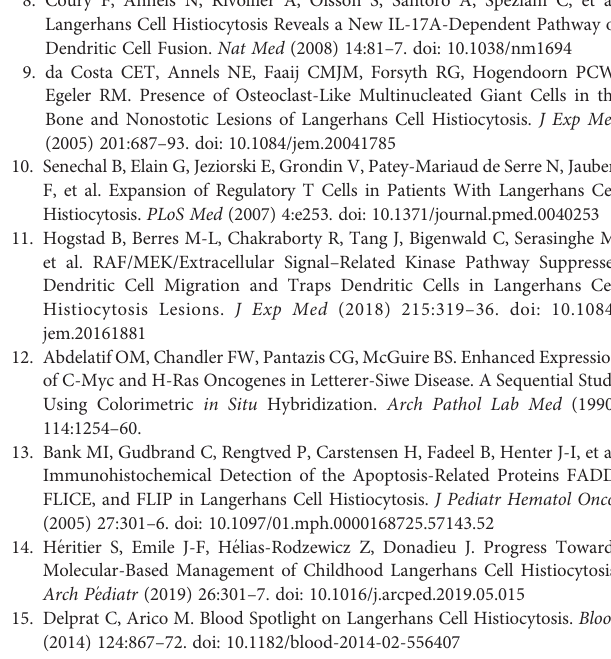
mediumalone(none)orhighdosesofVBL(HighVBL)orAraCand2CdA(HighAraC + 2CdA). Dot plots present SSC/FSC morphology to show the cells gated in G1 (left).Then,gatedinG1(right),dotplotspresenttheintracellularstainingwithisotype antibody control (control), shown for medium alone (none) and also representative of the two other culture conditions (not shown). Finally, three dot plots present the intracellular staining withanti-BCL2A1antibodies for thethree culture conditions,